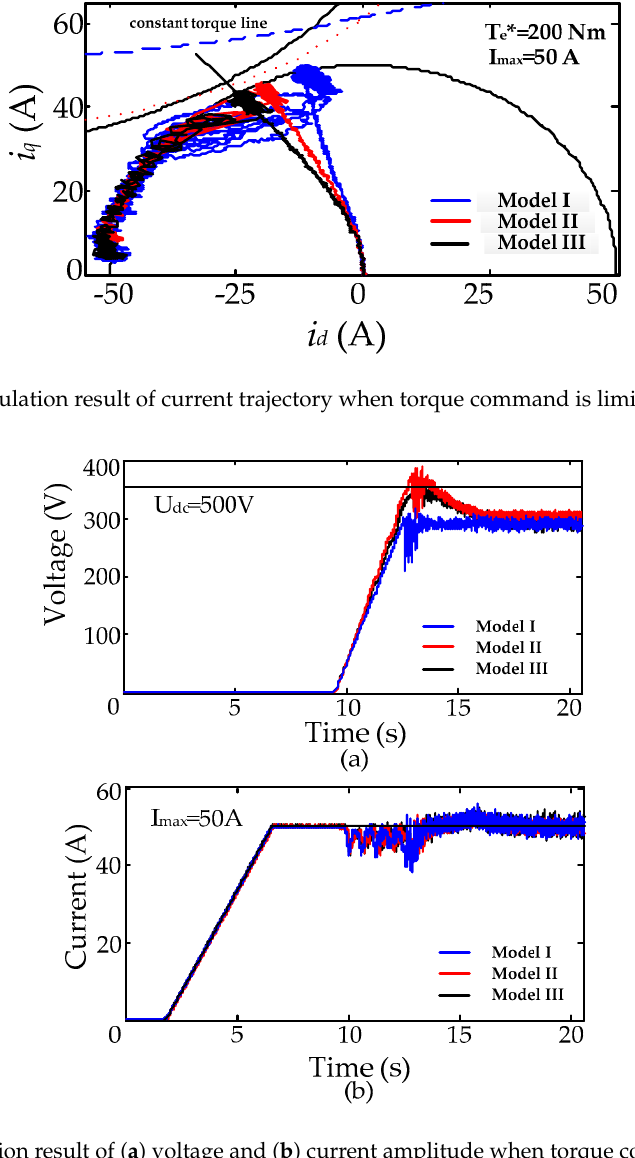
Figure 12. Simulation result of ( a ) voltage and ( b ) current amplitude when torque command is limited to 200 nm.